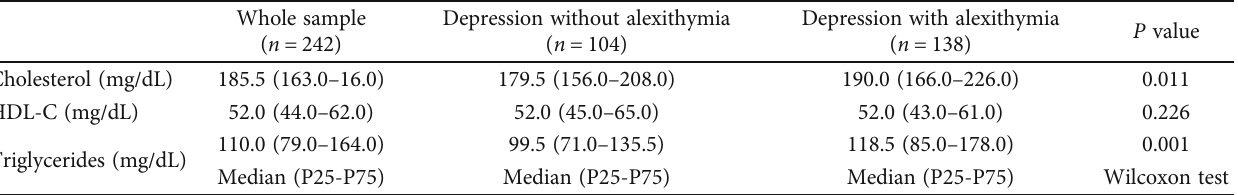
Table 5: Lipid pro fi le according to alexithymic status ( n = 242